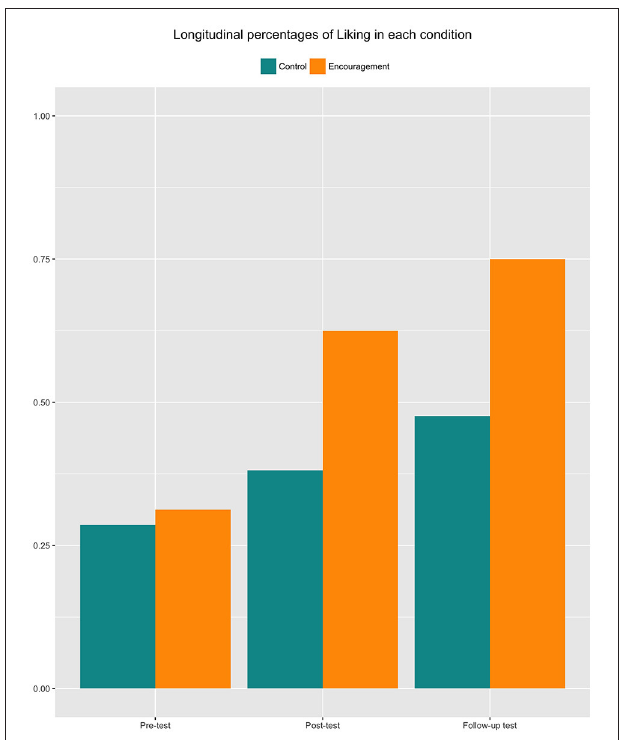
FIGURE 1 | Percentages of vegetable liking in 37 preschool children, for the tree measurement moments (pre-test, post-test, and follow-up) and two reward systems (control vs.